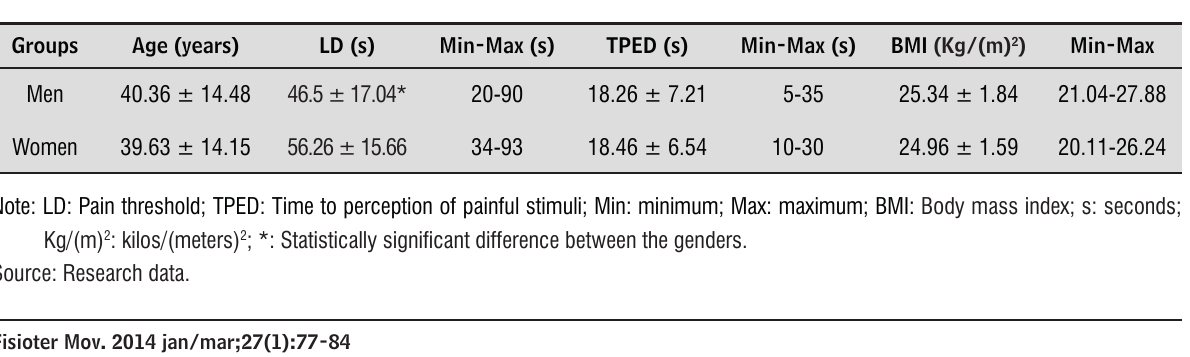
Table 2 - Representation of the subjects divided according to